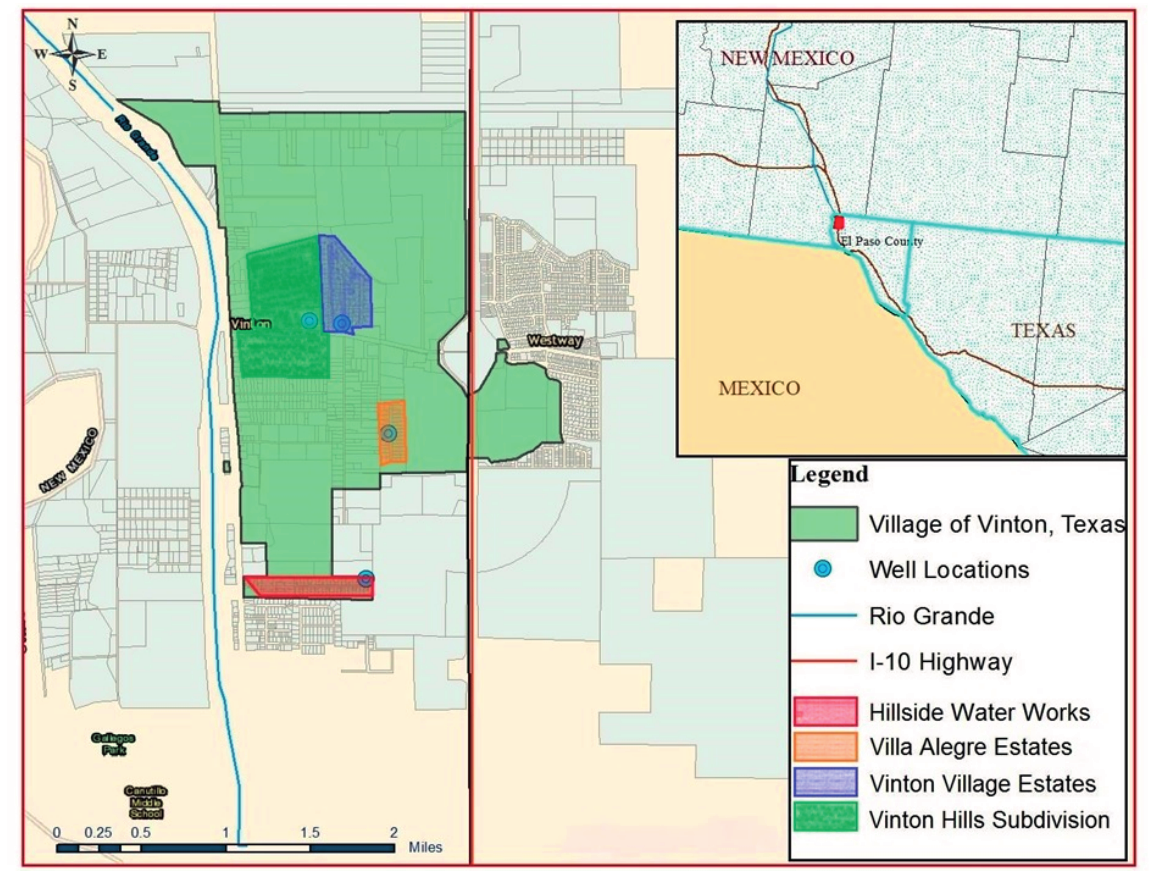
Figure 1. Map showing location and limits of Village of Vinton, and several small privately owned public water